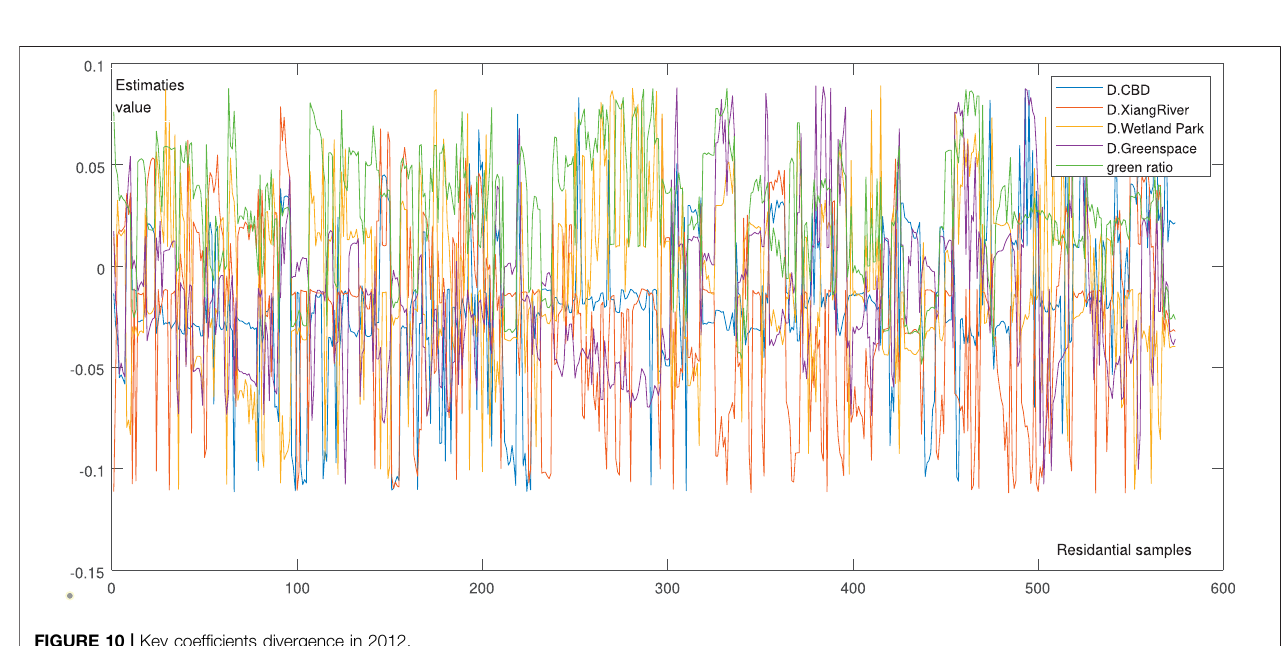
FIGURE 9 | Spatial and temporal variation of GS in fl uence coef fi cients in 2012, 2016 and 2020.